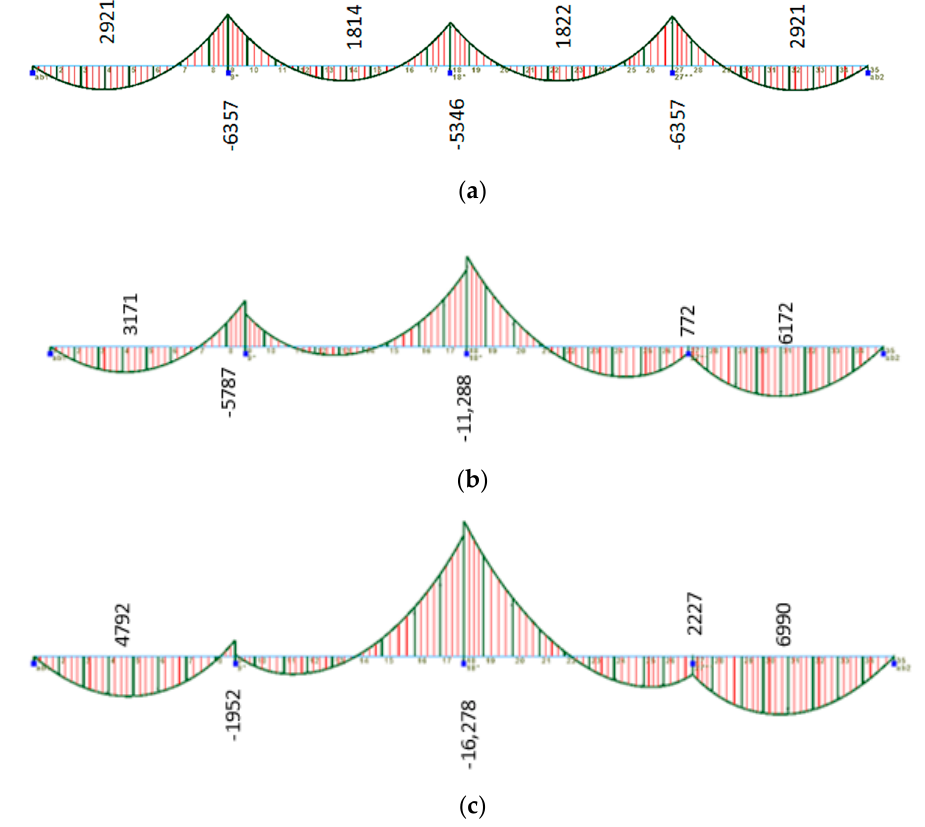
Figure 7. ( a ) Bending moment diagram—initial state (units in kN·m). ( b ) Bending moment diagram—settlement of 0.14 m under S3 (units in kN·m). ( c ) Bending moment diagram—settlement of 0.71 m under S3 (units in kN·m). (*, ** nodes at the bents).